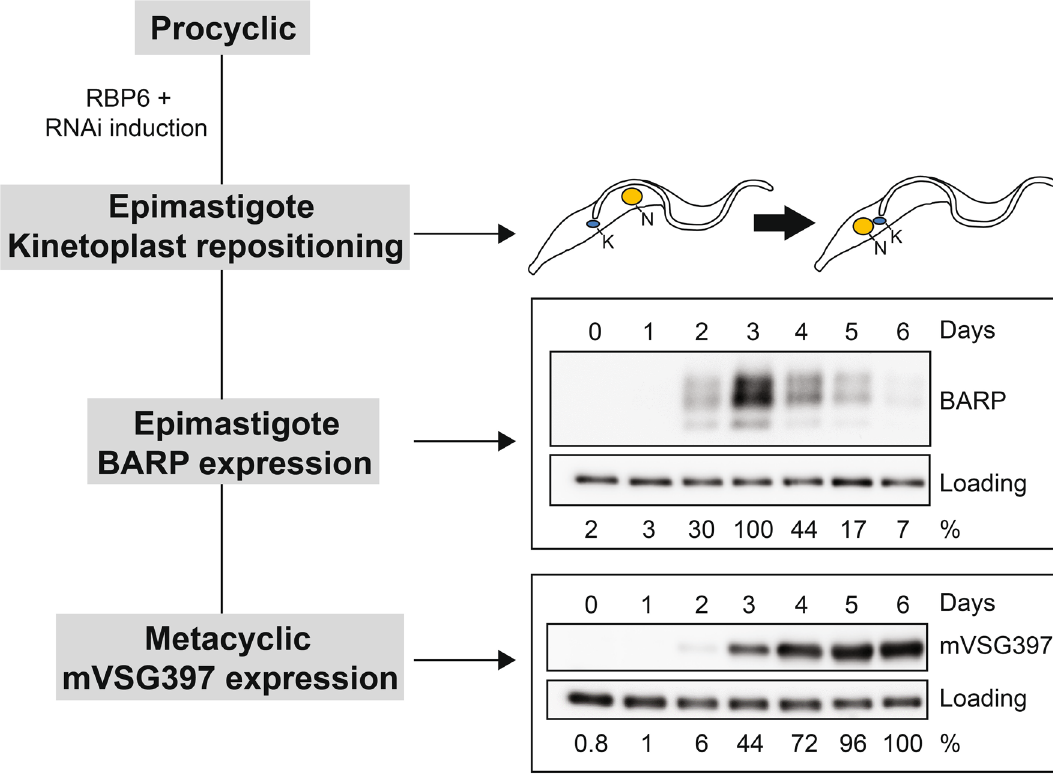
Figure 2. Targeted RNAi screen overview. BARP and mVSG397 are surface markers that serve as a positive readout for epimastigote and metacyclic production, respectively. Epimastigotes were quantified on the third day and metacyclics on the sixth day, since these are the times where BARP and mVSG397 expression was highest in our 6-day time course. Each RNAi cell line was induced with doxycycline to overexpress RBP6